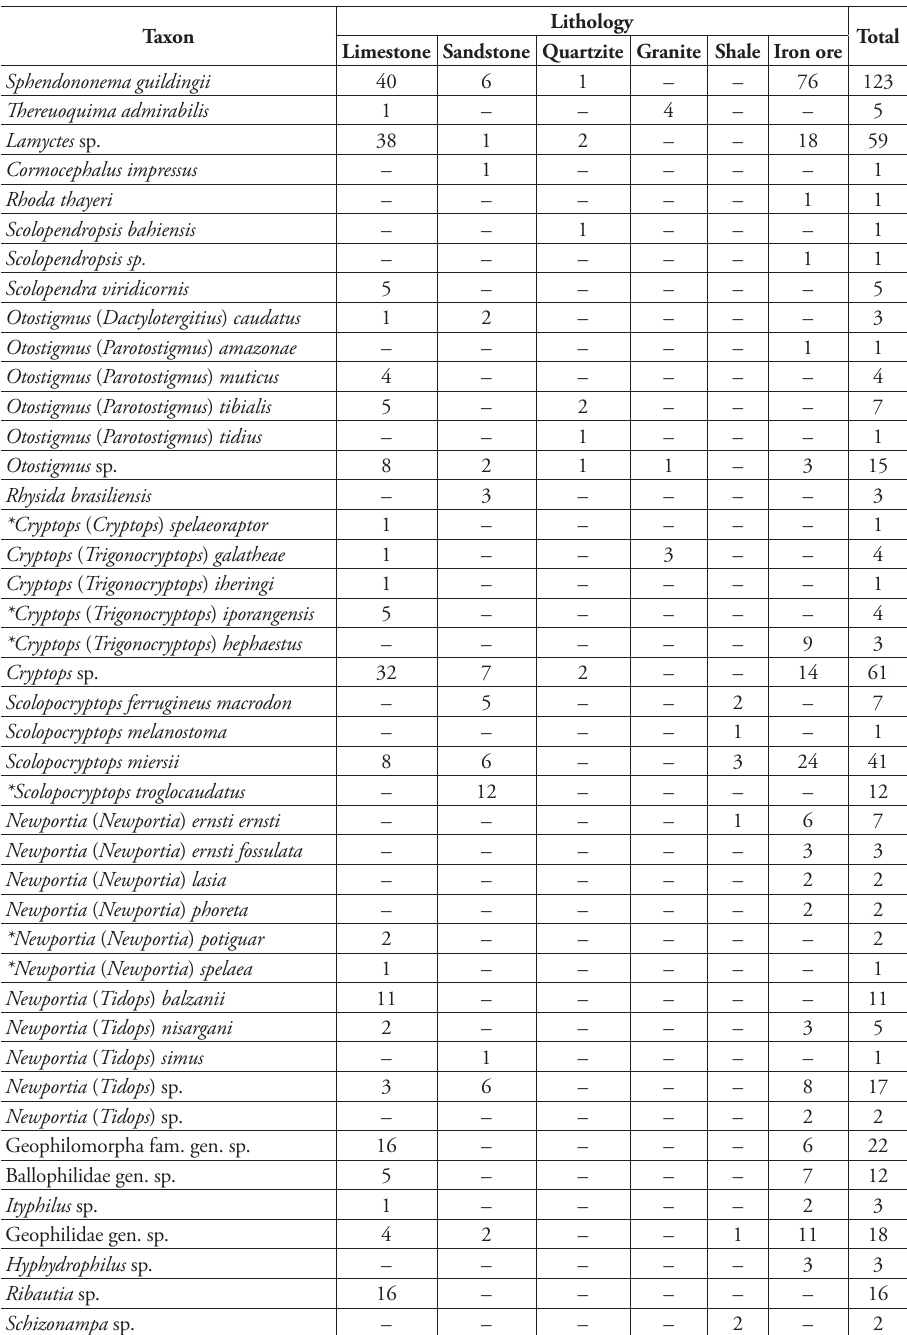
Table 2. Distribution and number of records of centipedes from Brazilian caves per lithology. An asterisk (*) denotes species found exclusively in